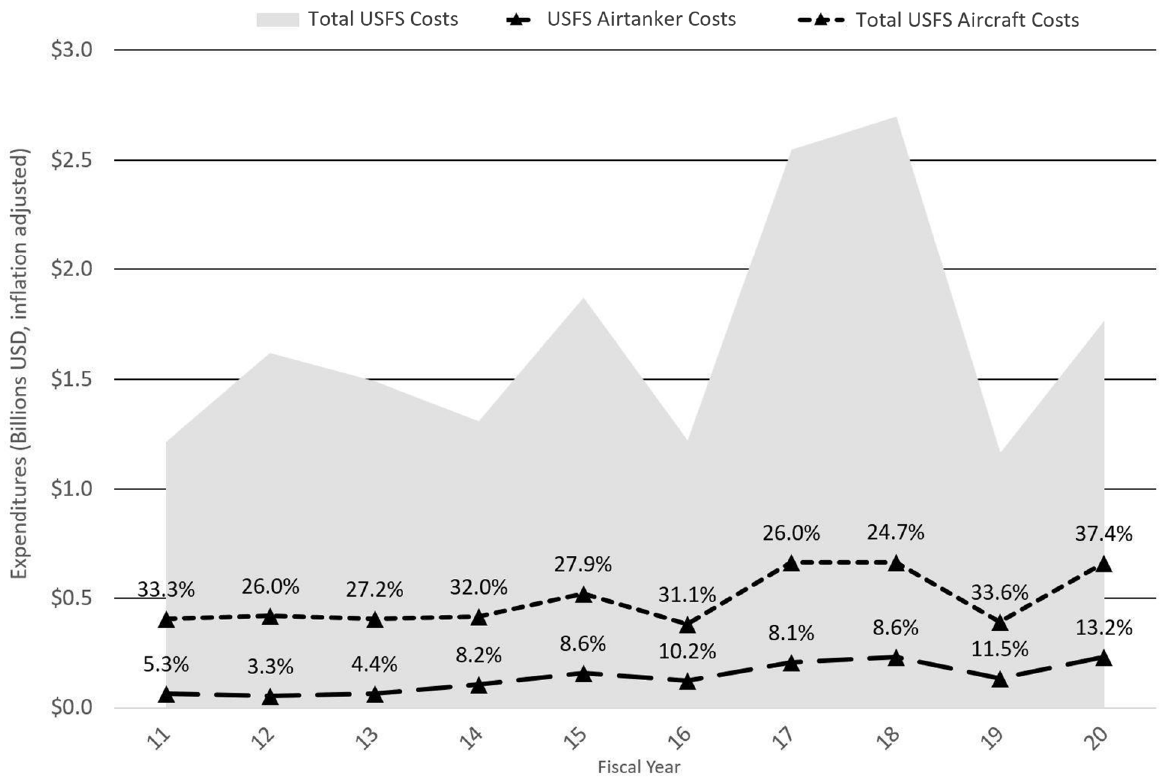
Figure 1. US Forest Service (USFS) wildfire suppression expenditures versus aviation costs by fiscal year (1 October through 30 September). Costs are fiscal year totals in 2020 US dollars, adjusted for inflation (CPI; https://www.bls.gov/regions/mid-atlantic/data/consumerpriceindexhistorical_us_table.htm (accessed on 28 July 2021)). USFS expenditures are from the National Interagency Fire Center (NIFC) published report [10]. Airtanker and all aircraft costs are obtained from USFS Aviation Business System (ABS) data and include all Agency costs, not limited to fire suppression. Non-fire costs average less than 5% of total aviation costs annually and are not omitted here due to data limitations and inconsistencies in ABS coding between analysis years.